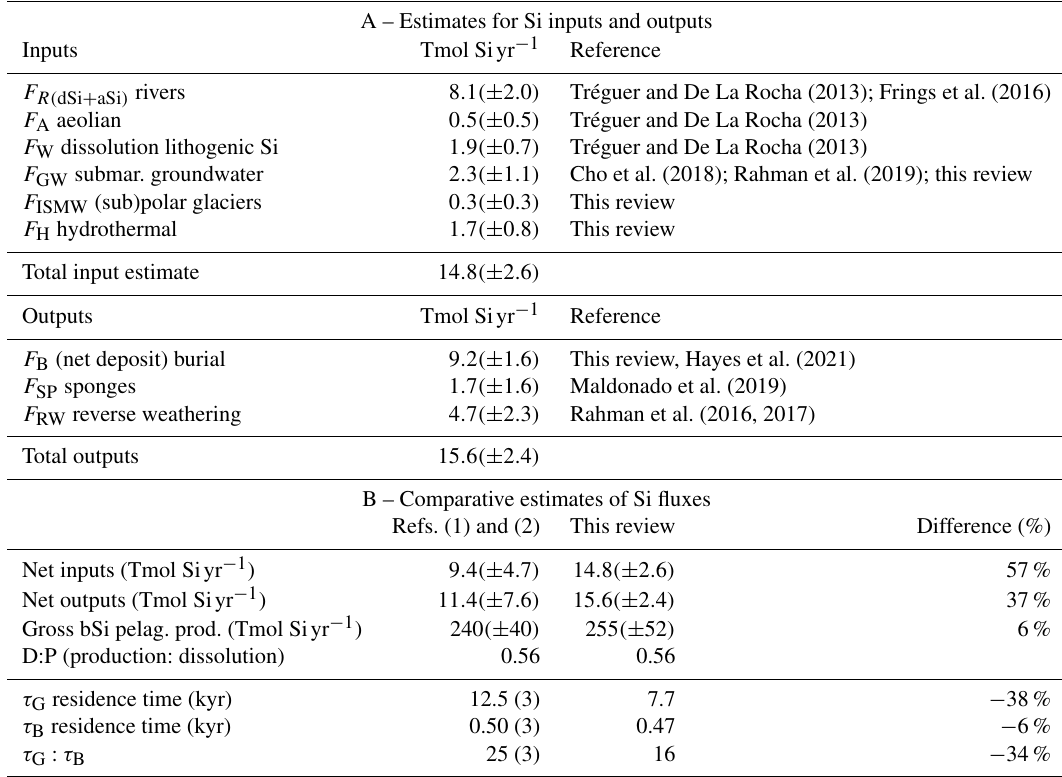
Table 1. Si inputs, outputs, and biological fluxes at word ocean scale.